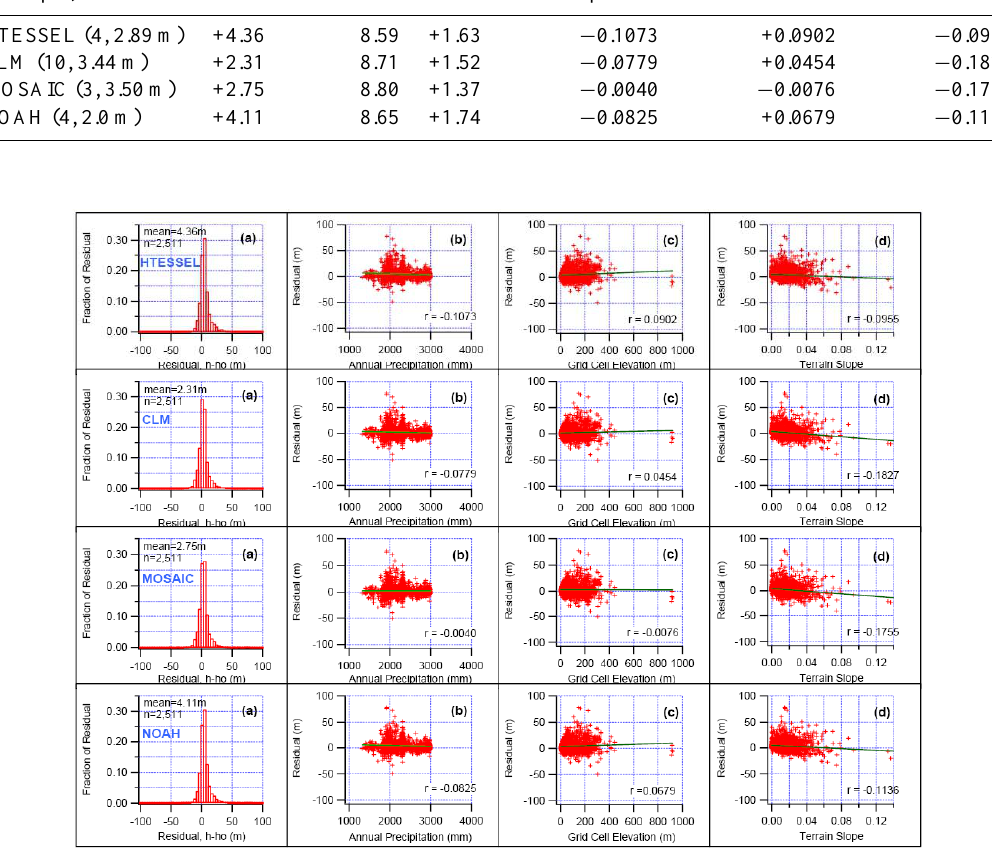
Fig. 7. Same as Fig. 6, but for validation over the Amazonia (outline shown in Fig. 1).